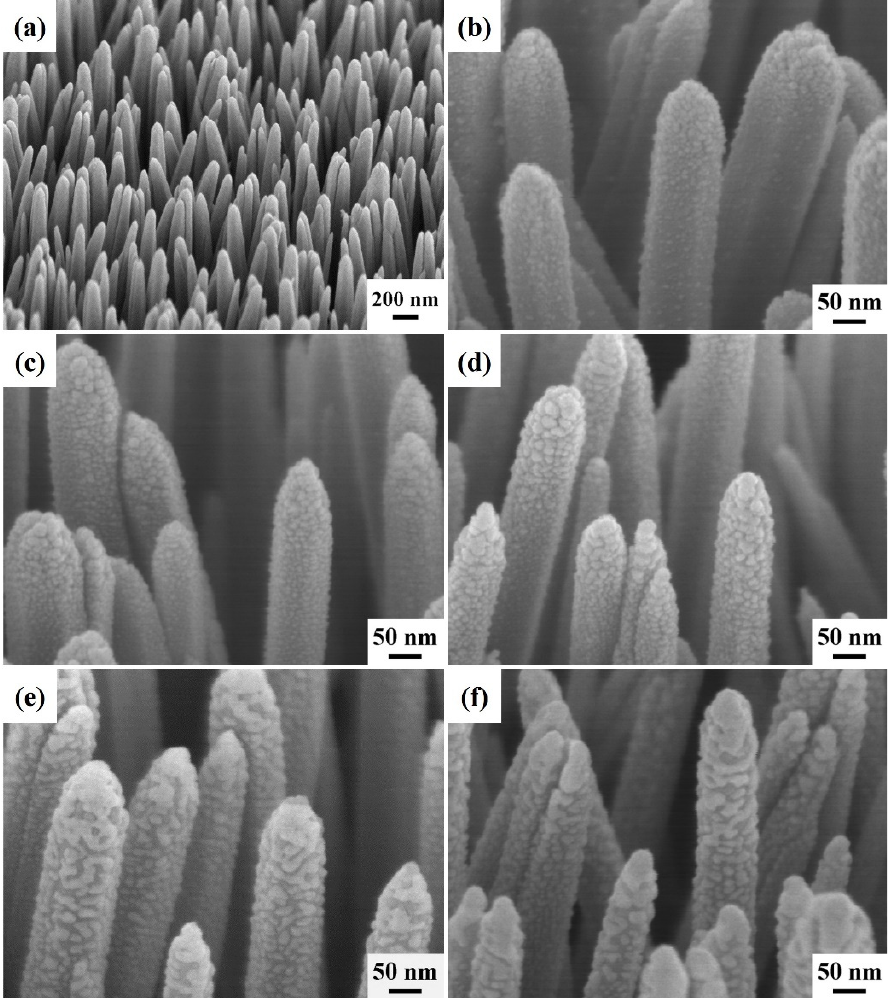
Figure 2. Tilt-view FESEM images of ( a ) ZnO: Ga nanotowers and ( b – f ) ZnO: Ga@Ag nanotowers with different Ag ion-sputtering times grown on glass substrates with a ZnO seed film. The ion- sputtering times are ( b ) 15, ( c ) 30, ( d ) 60, ( e ) 90, and ( f ) 120 s, respectively.